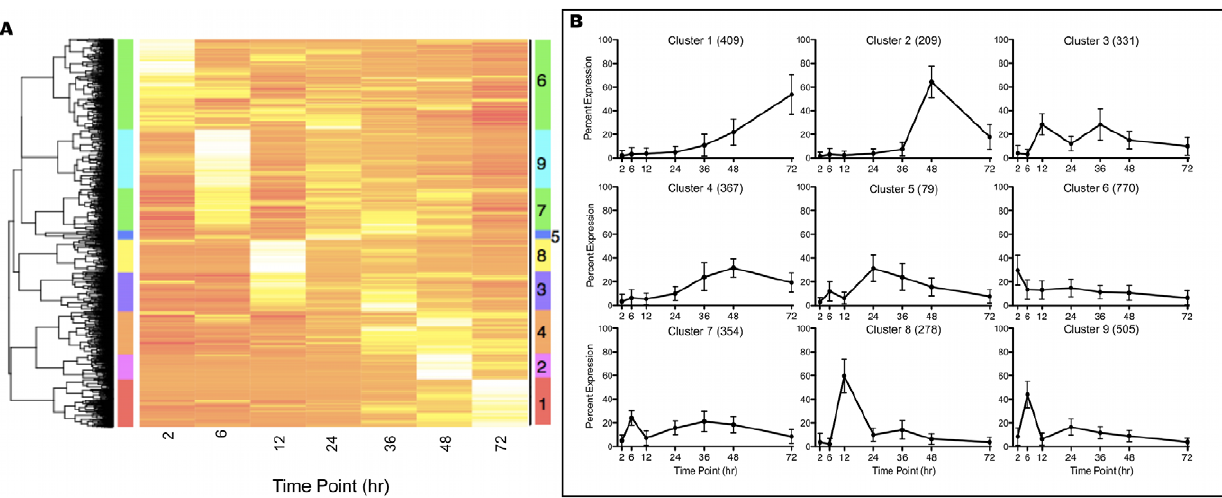
Figure 4. C.parvum Transcriptome 2–72 hr Relative Expression Cluster Analysis. The DIANA algorithm was used to cluster each gene’s relative expression using the absolute cosign distance metric. For the heatmap each gene is represented in one row and each column represents the percent expression at one time point. ( A ) The relative expression (%) was determined for each gene’s median normalized value over the 7 time point, 72 hr time course (3302 genes). Nine clusters (1–9) are present with the dendrogram distance cutoff of 100 as indicated with the colored bar to the right of the heatmap. ( B ) For the 72 hr time course, each clusters’ average expression ( + / 2 SD) is graphed, with the number of genes found in each cluster within the parentheses.